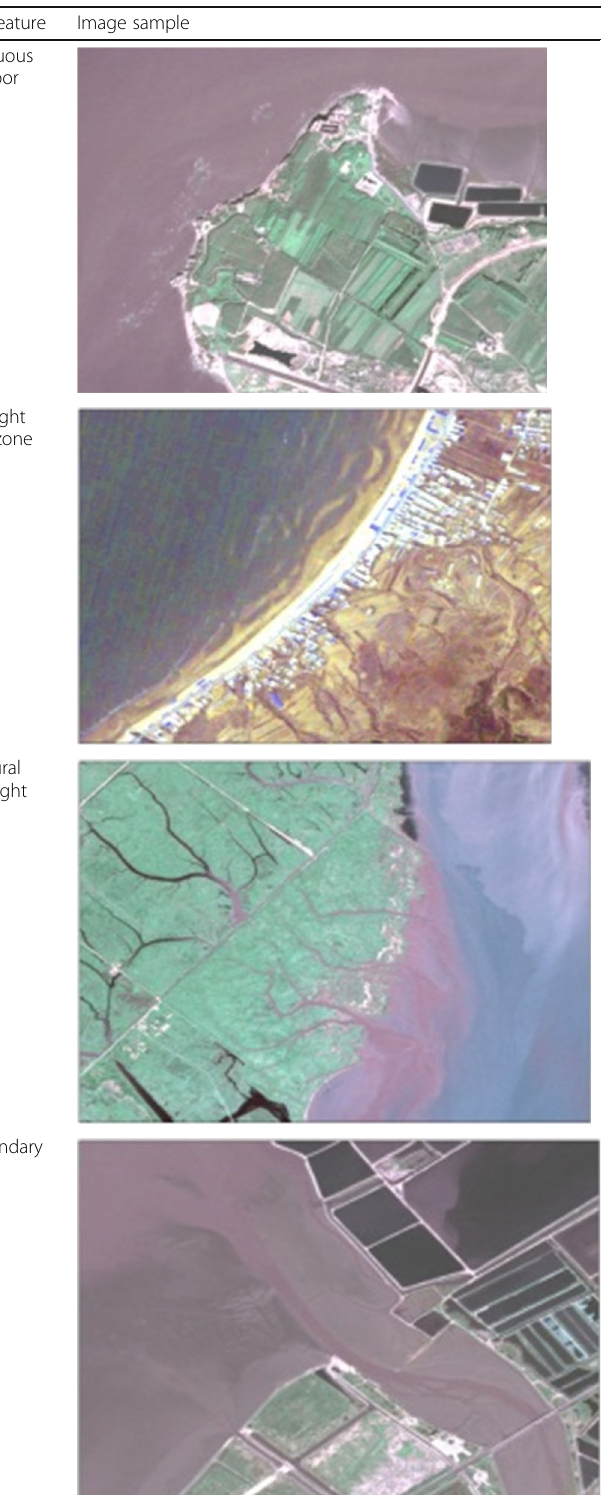
Table 3 Image characteristics of coastline